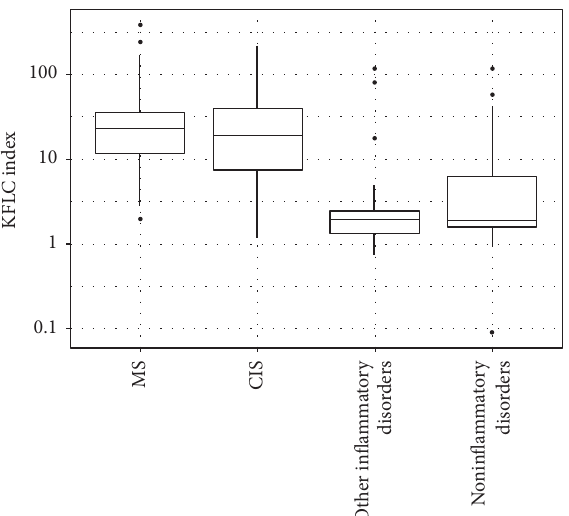
Figure 1: Median values and ranges of KFLC index in different subgroups: multiple sclerosis (MS) subgroup; clinically isolated syndrome (CIS) subgroup; other inflammatory disorders subgroup; noninflammatory disorders subgroup.